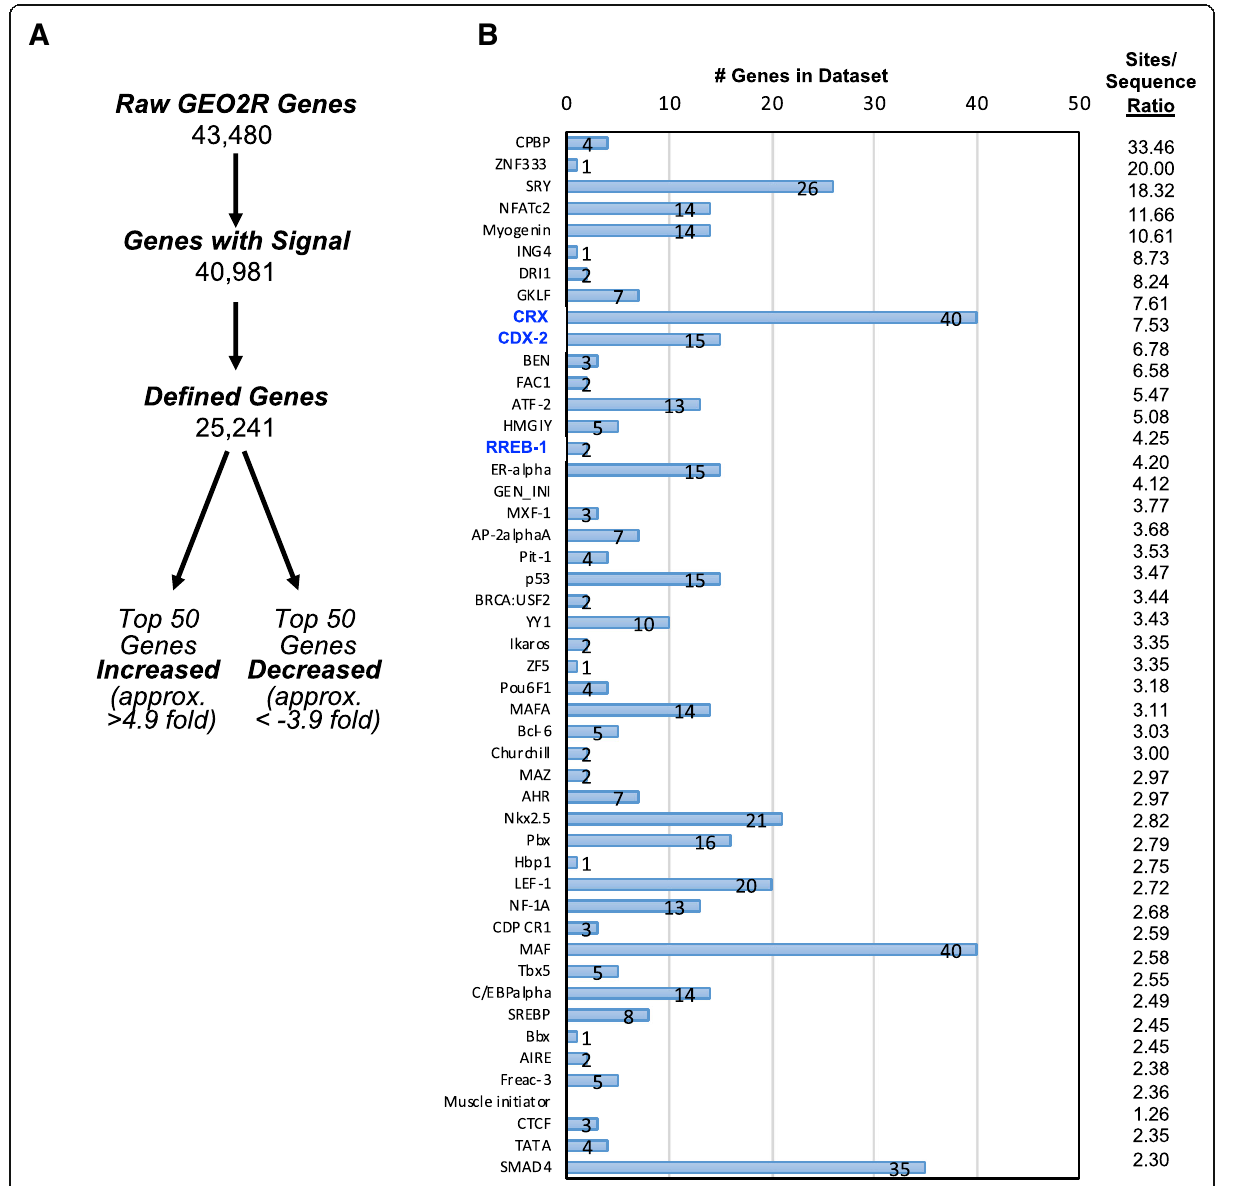
Fig. 6 Differentially expressed genes in a rat model of CH-induced pulmonary hypertension and right heart failure. a. Summary of how differentially expressed genes in CH-induced rat heart failure resulted in top 50 increased genes (>4.9-fold) and top 50 decreased genes (<3.9-fold) compared to normoxia using data from Drake, et al., 2013 [2]. Genes summarized in Additional file 4: Figure S2. b. Identification of transcription factors with binding sites of top 50 increased and top 50 decreased genes. The number of genes in the dataset and enrichment (sites/sequence ratio) for each transcription factor is calculated to the